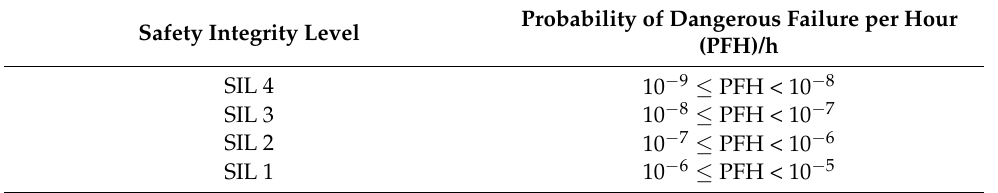
Table 2. Quantitative SIL requirements.